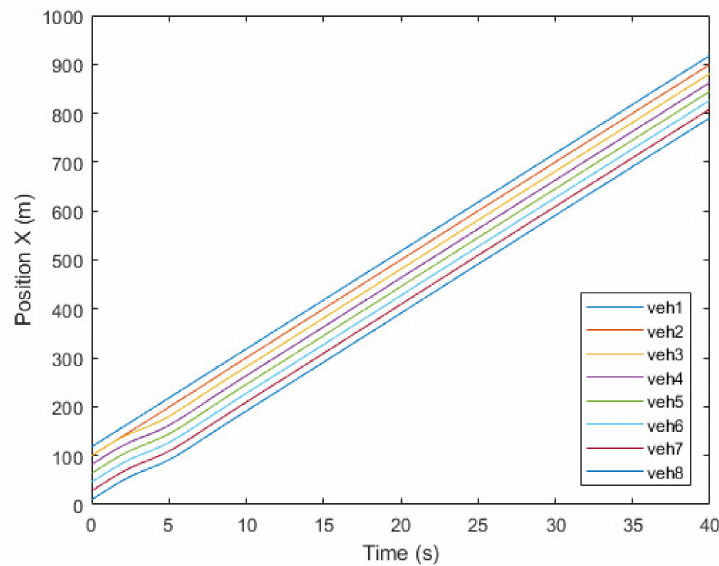
Figure 8. Position of vehicles.